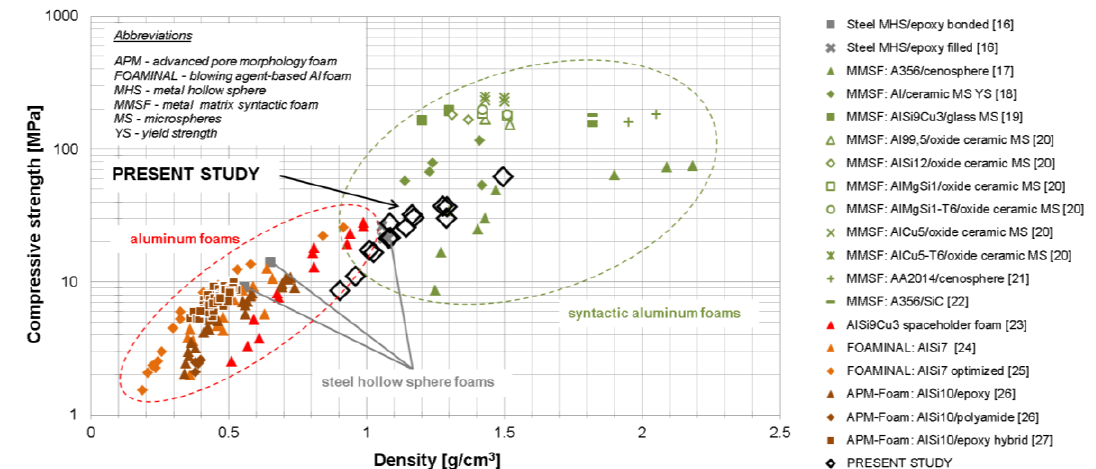
Figure 4. Comparing the mechanics of Cu@CS materials with other types of foams: Absolute compressive strength values of similar density materials are contrasted. Note that exact strength definitions may differ slightly between material variants. An explanation of abbreviations used in the diagram is provided in the upper left corner. The representation as such follows Weise et al. [4]. The data shown were collated from references [16–27].